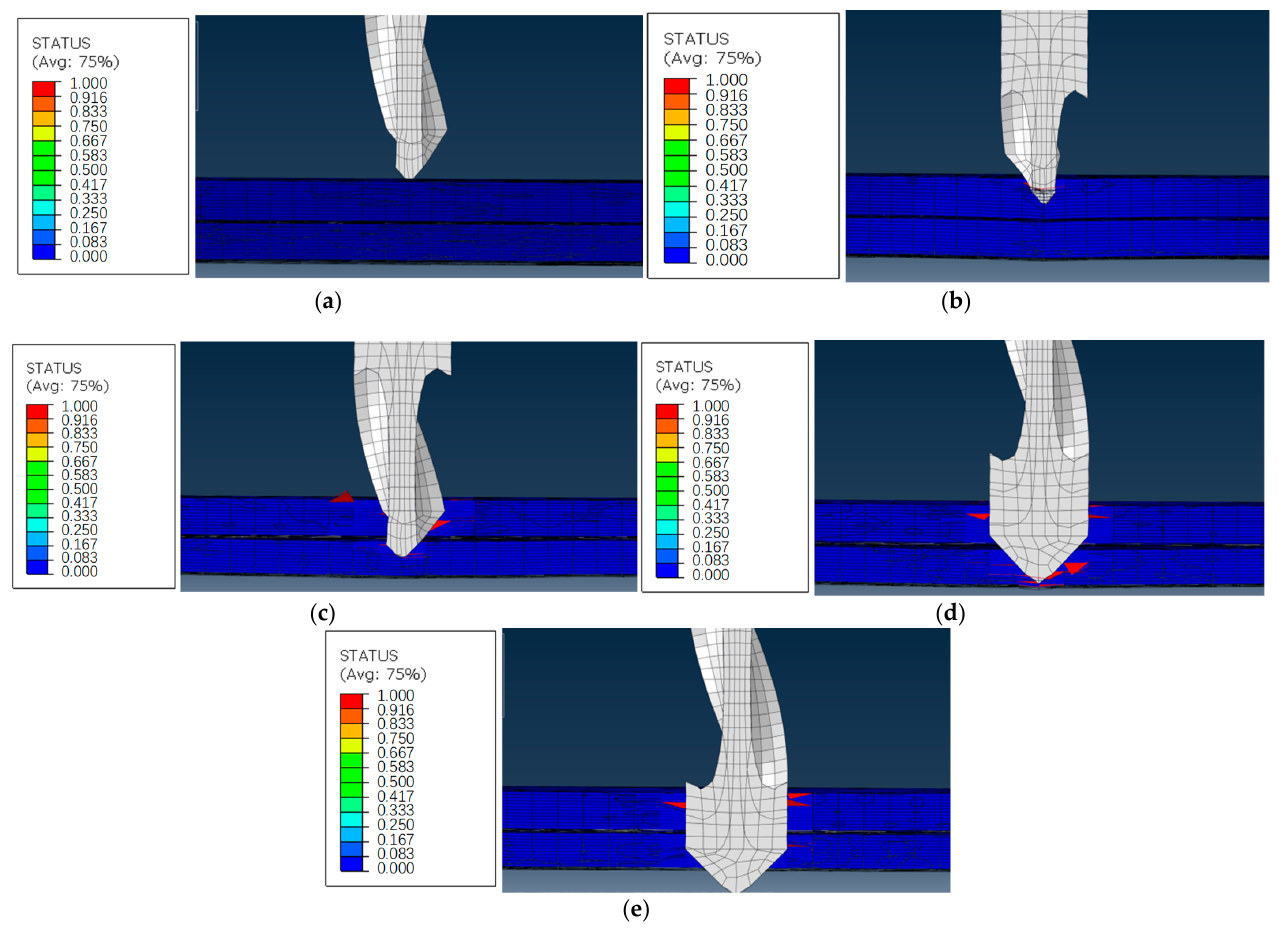
Figure 8. Drilling Stages: ( a ) Initial stage, ( b ) Blade feed, ( c ) Delamination cutting, ( d ) Critical stage, ( e ) Drilling out stage.